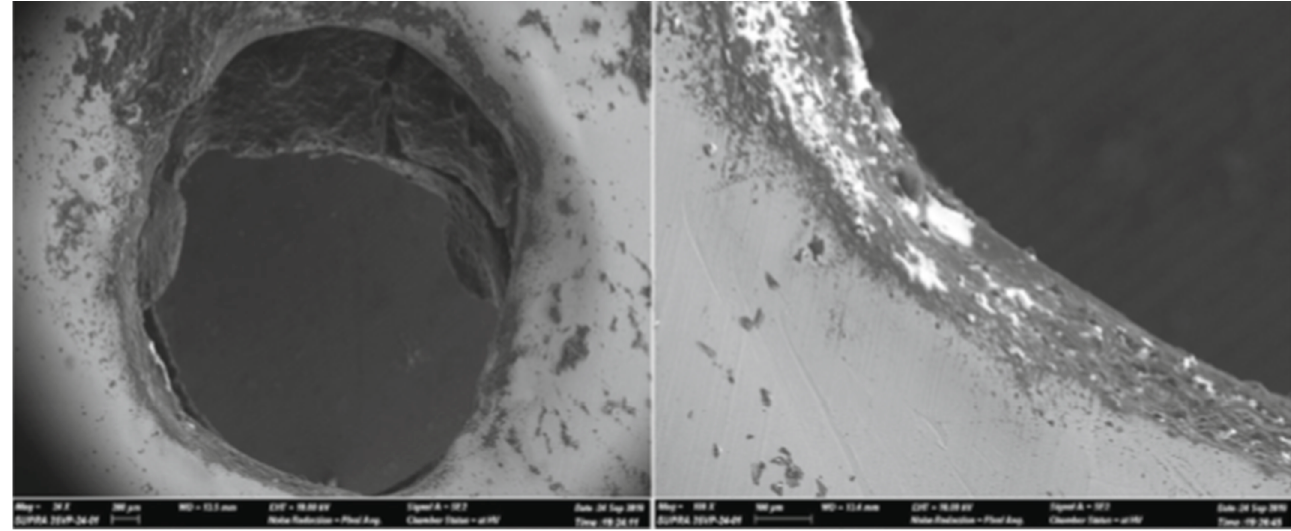
Figure 27. SEM images showing micro-holes produced in AlN by the micro-EDM process [137]. (With kind permission from Springer).